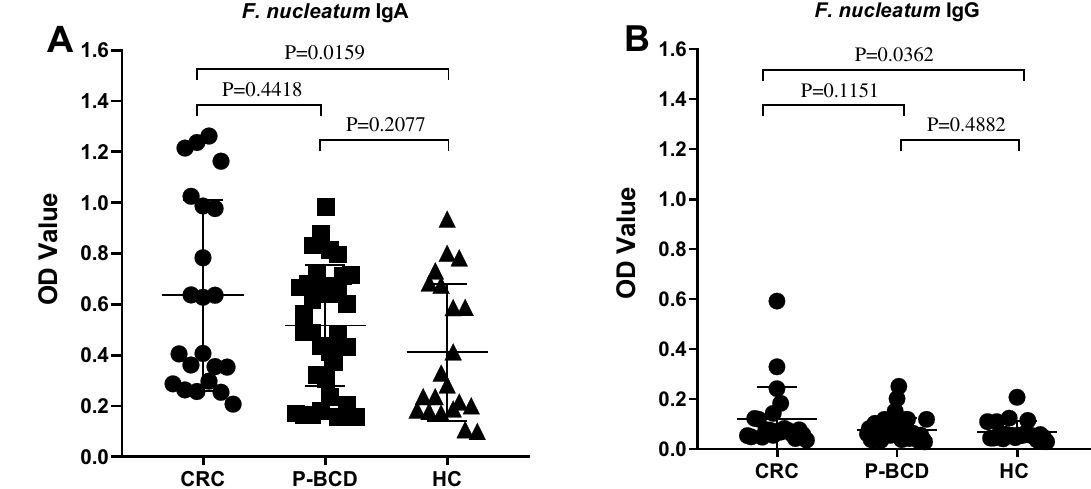
Figure 2. Comparison of OD values from F. nucleatum IgA and IgG ELISA in sera of CRC (n = 22), P-BRC (n = 35) and HC (n = 21) groups. Symbols indicated individual OD value; horizontal lines indicated mean values ± SD. (A) F. nucleatum IgA. (B) F. nucleatum IgG.